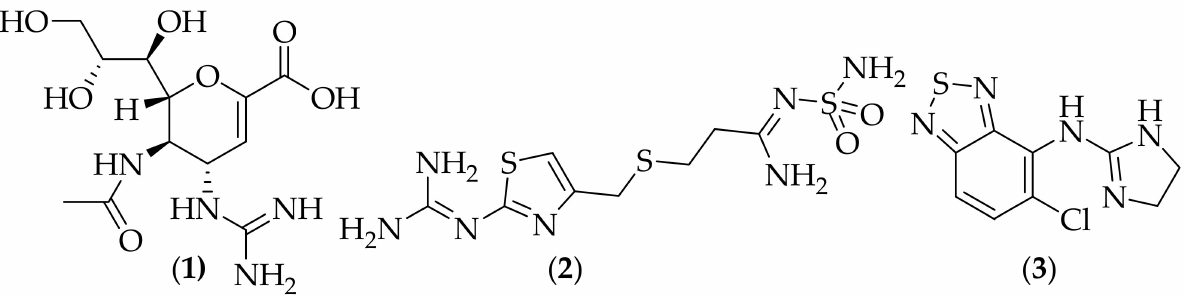
Figure 1. Structures of representative guanidine-containing approved drugs. zanamivir (Relenza) ( 1 ), famotidine (Pepcid), ( 2 ), and tizanidine (Zanaflex) ( 3 ).